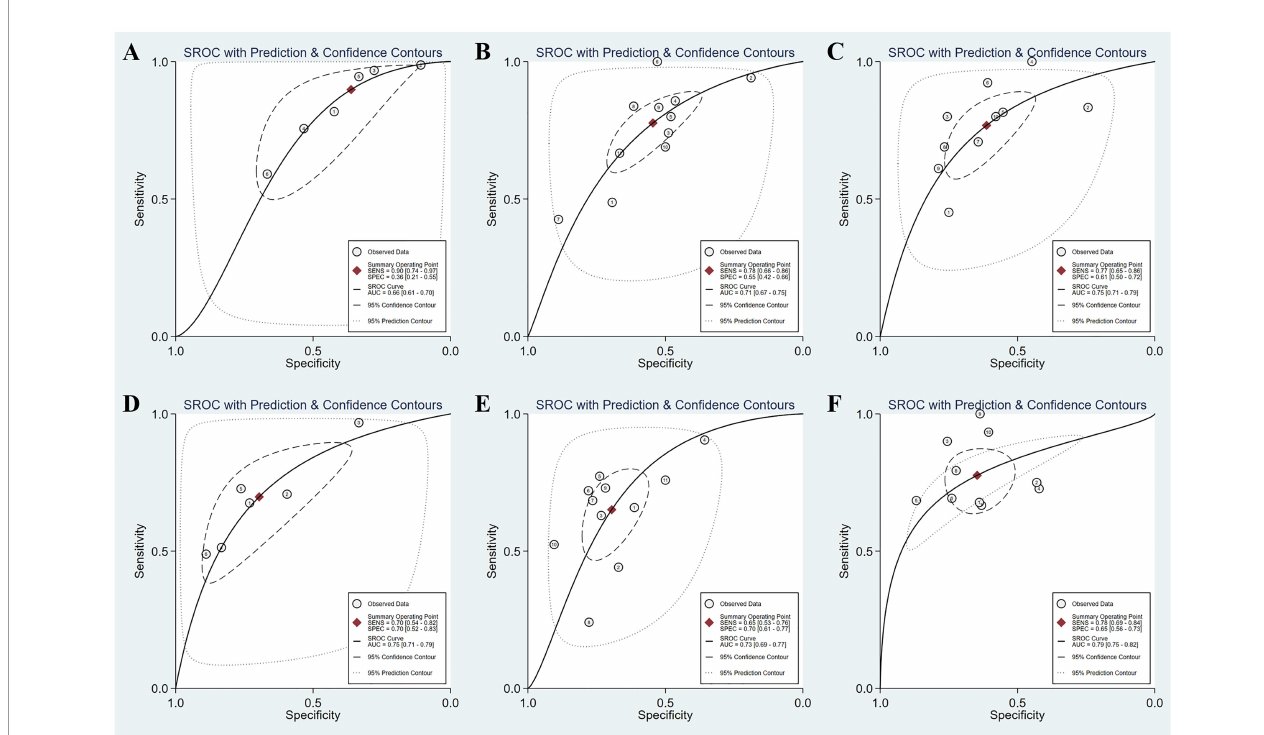
FIGURE 4 | SROC curves of the diagnostic performance of APRI and FIB-4 for the prediction of liver fi brosis in AIH patients. (A) APRI for detecting signi fi cant fi brosis; (B) APRI for detecting advanced fi brosis; (C) APRI for detecting cirrhosis; (D) FIB-4 for detecting signi fi cant fi brosis; (E) FIB-4 for detecting advanced fi brosis; (F) FIB-4 for detecting cirrhosis.